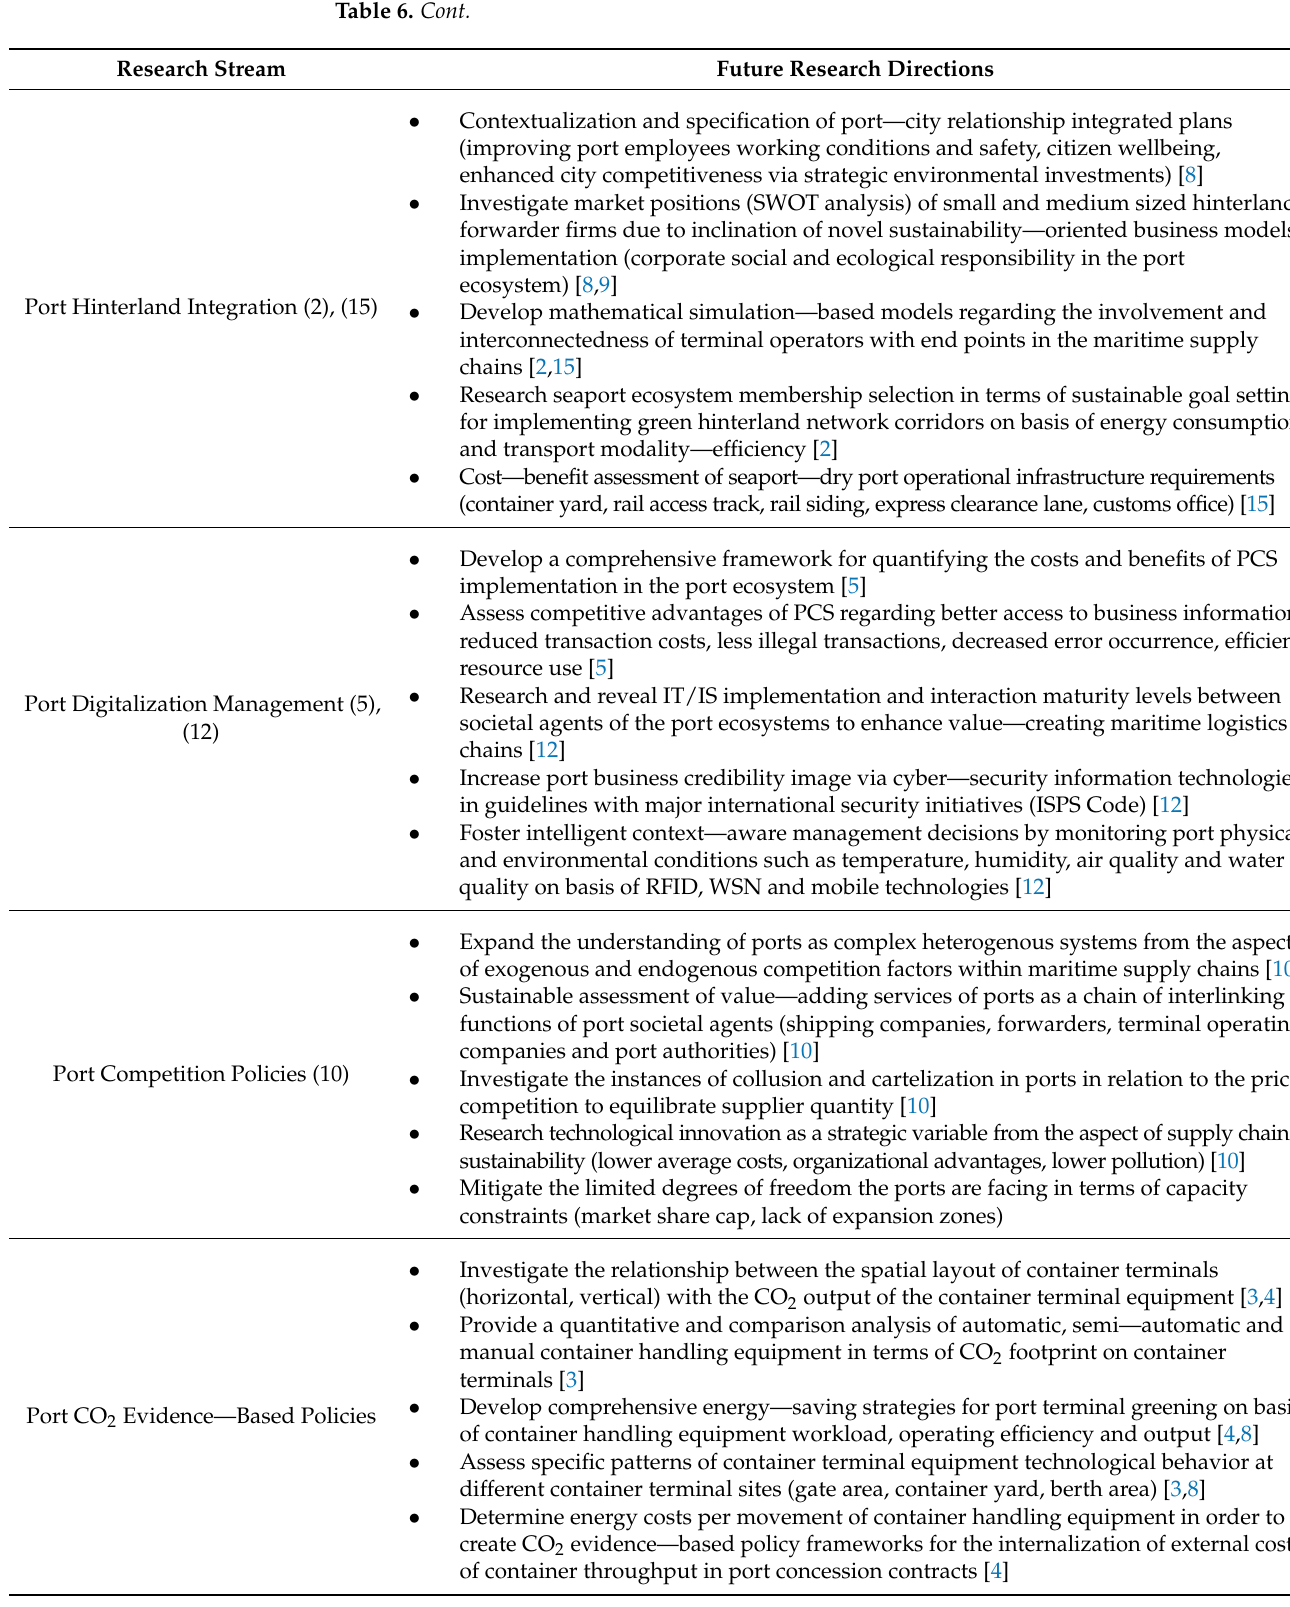
the port greening process stem from the combination of the following three green